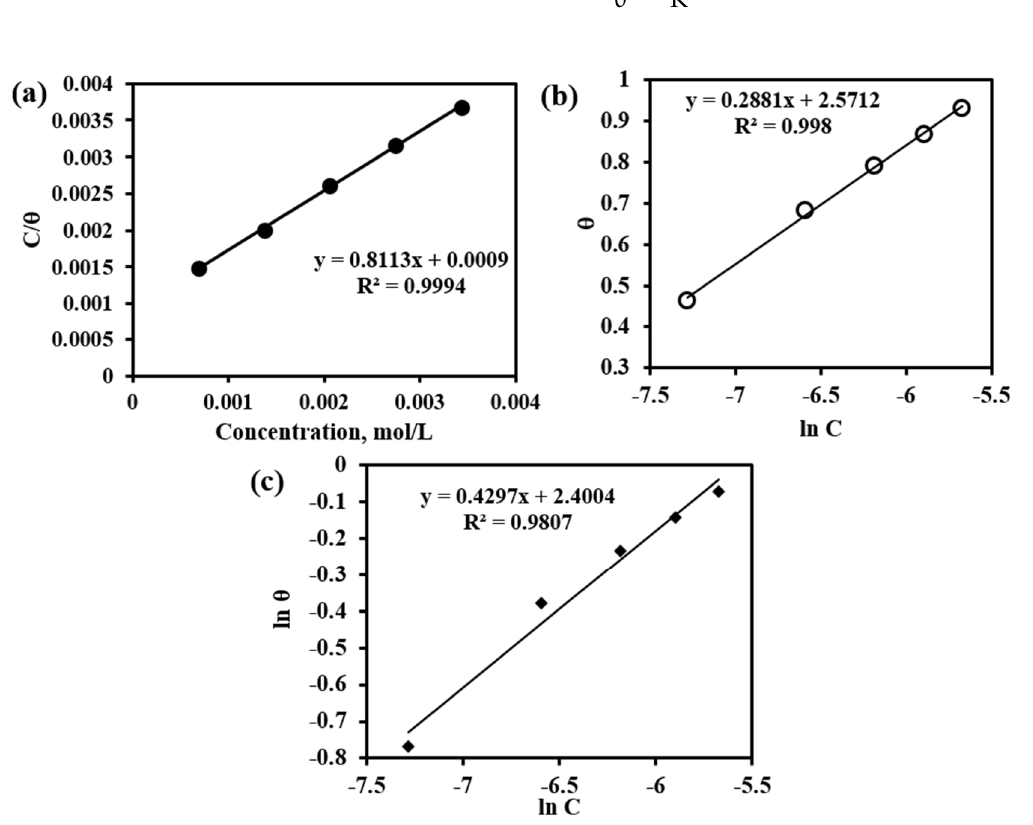
Figure 11. ( a ) Langmuir Adsorption Isotherm, ( b ) Temkin Adsorption Isotherm, and ( c ) Freundlich Adsorption